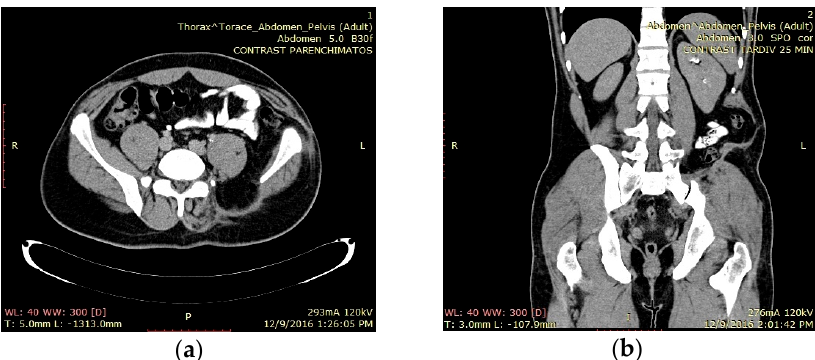
Figure 5. ( a , b ) Case 3. Axial and coronal pelvic CT scan performed at 18 months postresection, indicating no sign of recurrence.